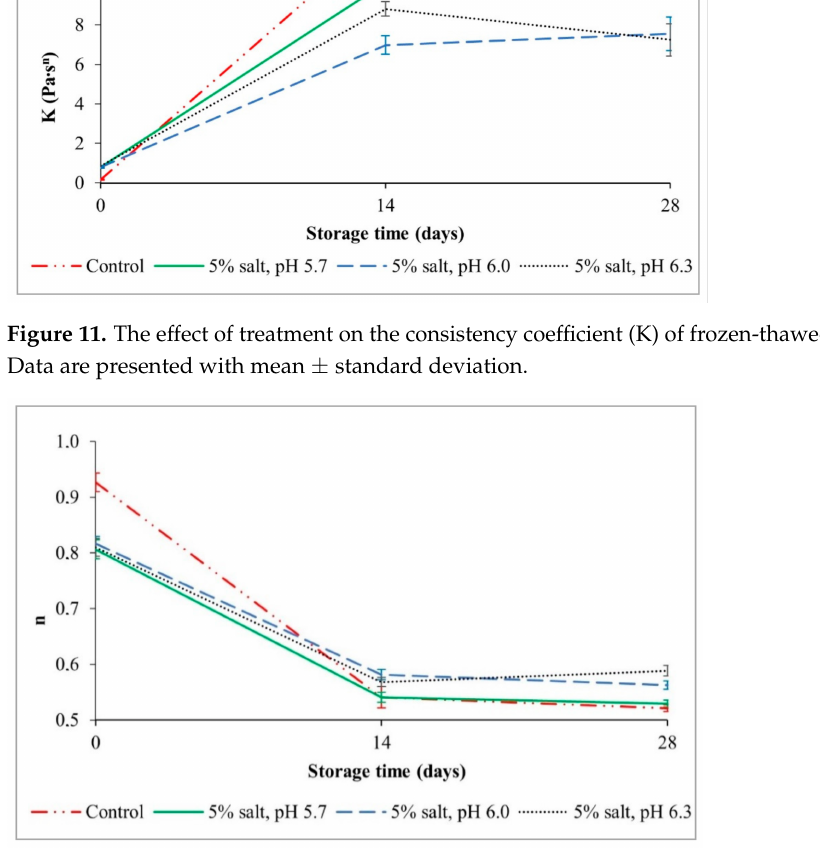
Figure 12. The effect of treatment on the flow behaviour index (n) of frozen-thawed liquid egg yolk. Data are presented with mean ± standard